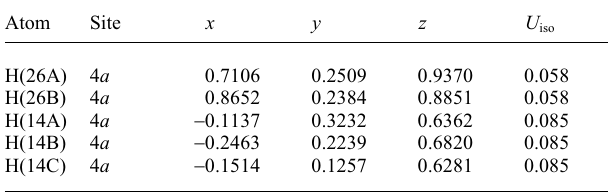
Table 3. Atomic coordinates and displacement parameters (in Å 2 )